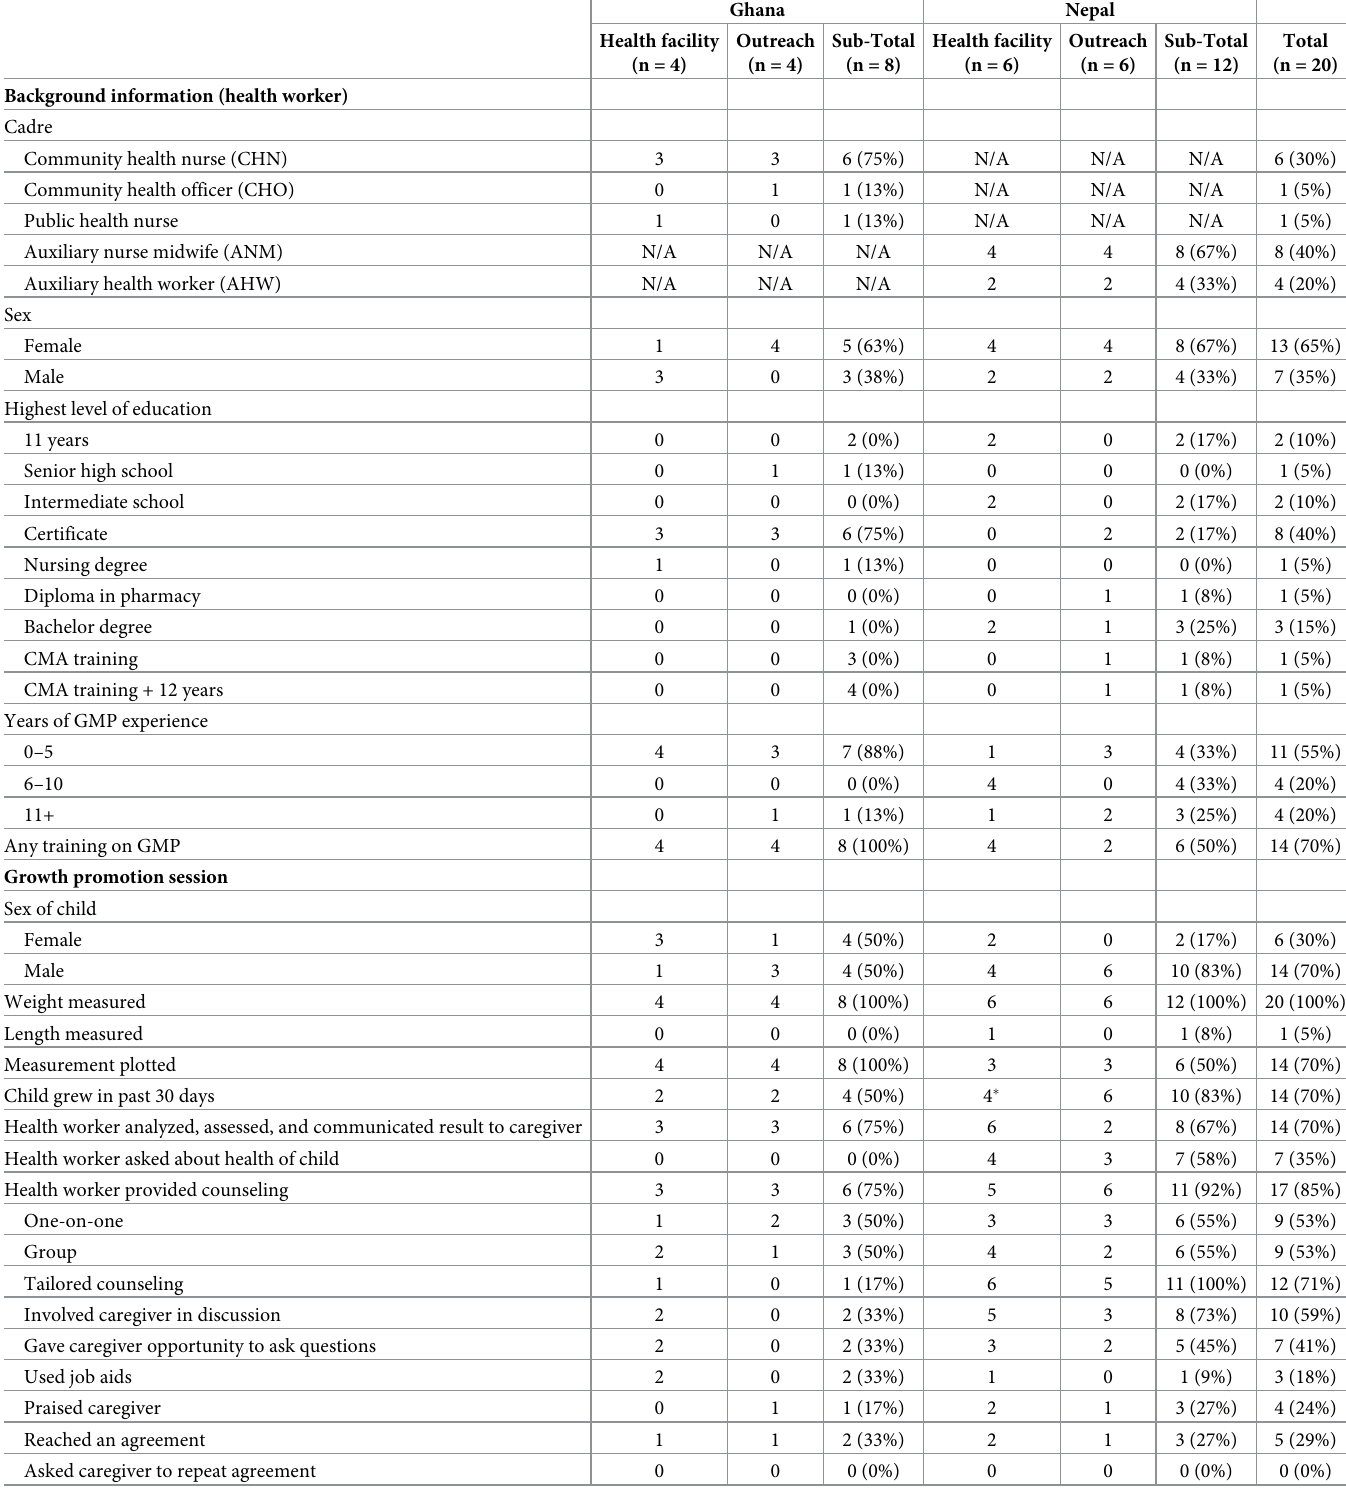
Table 4. GMP practices observed in Ghana and